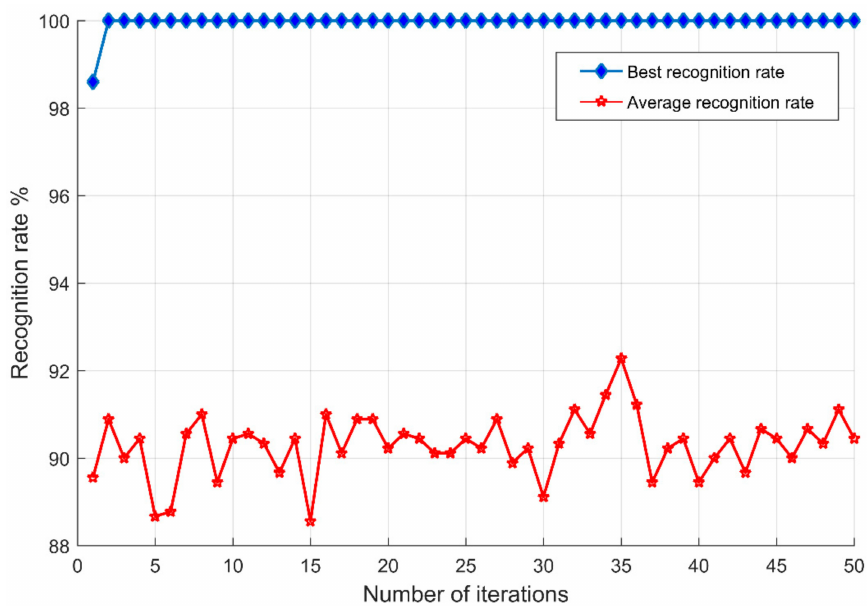
Figure 5. The recognition rate curve of IFA-WSVM model.